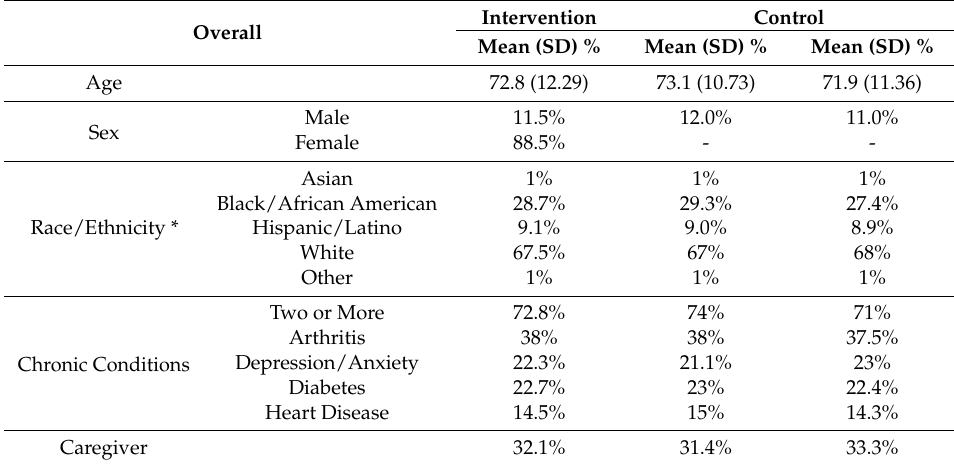
Table 1. Demographics ( n =